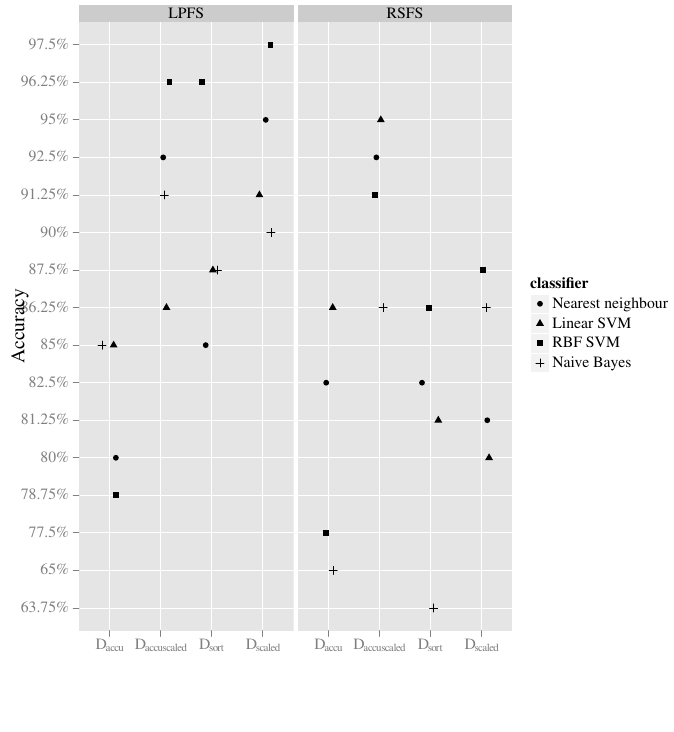
Figure 7. Classification results of using 4 different classifier models on 4 different data mappings using the RSFS and the LPFS